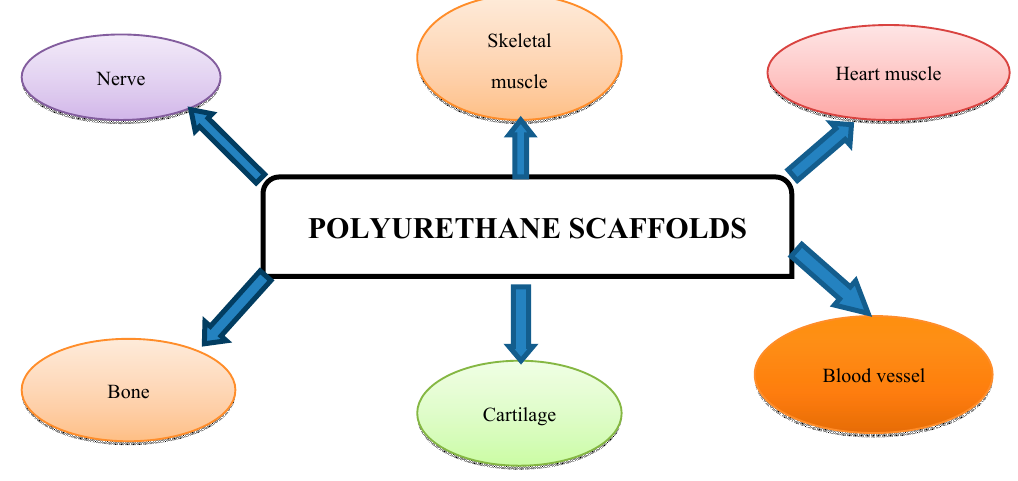
Figure 3. Types of PU scaffolds.